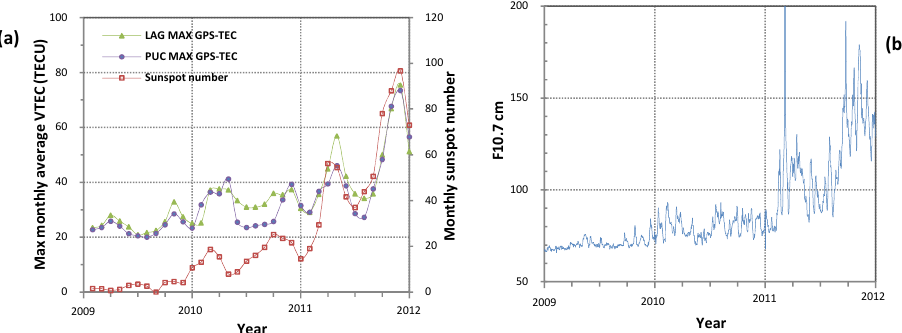
Fig. 4(a) Plots of monthly sunspot number and the maximum monthly average value of Fig. 4. (a) Plots of monthly sunspot number and the maximum monthly average value of monthly VTEC for 2009, 2010, and 2011 (b) plot monthly VTEC for 2009, 2010, and 2011 (b) Plot of F10.7 cm solar flux for 2009, 2010, and of F10.7cm solar flux for 2009, 2010, and 2011. 2011.